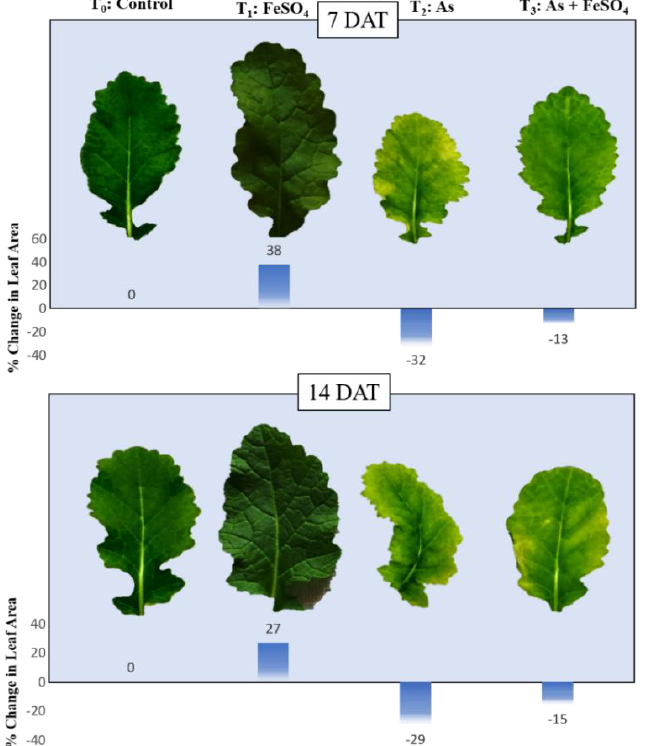
Figure 3. Impact of iron sulfate (T 1 : +FeSO 4 ), arsenic stress (T 2 : +As) and iron sulfate supplementation during As stress (T 3 : As+FeSO 4 ) on leaf morphology and percent (%) change in leaf area of Brassica during As stress (T 3 : As + FeSO 4 ) on leaf morphology and percent (%) change in leaf area of Brassica juncea studied 7 and 14 days after treatment (DAT). juncea studied 7 and 14 days after treatment